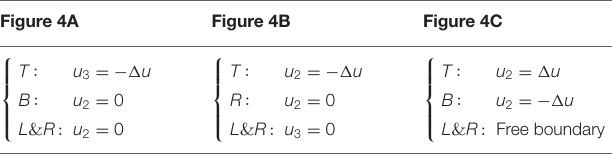
TABLE 1 | The boundary conditions for the three models ( Figure 4